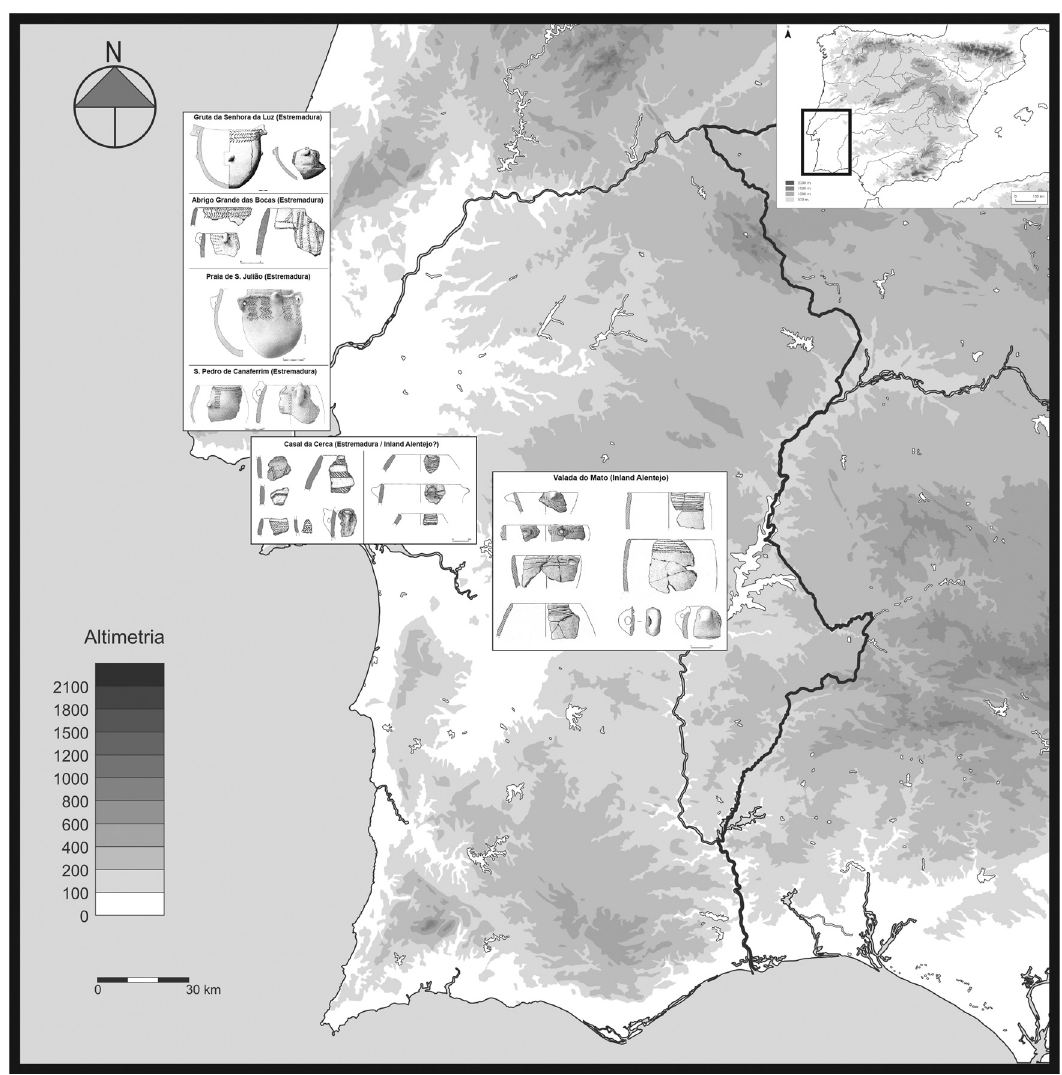
Figure 3: Evolved Early Neolithic. Pottery decoration systems distribution ( according to: Cardoso et al., 1996; Carreira, 1994; Diniz, 2007; Silva & Soares, 2014; Simões, 1999; basemap: Boaventura, 2009; Trabajos de Prehistoria for the map of Iberia )